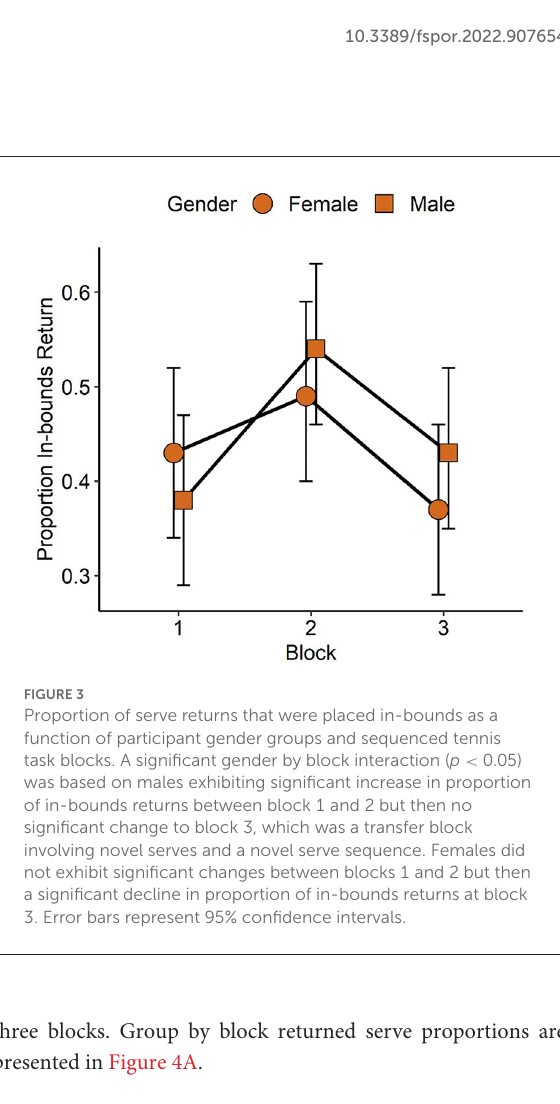
three blocks. Group by block returned serve proportions are presented in Figure